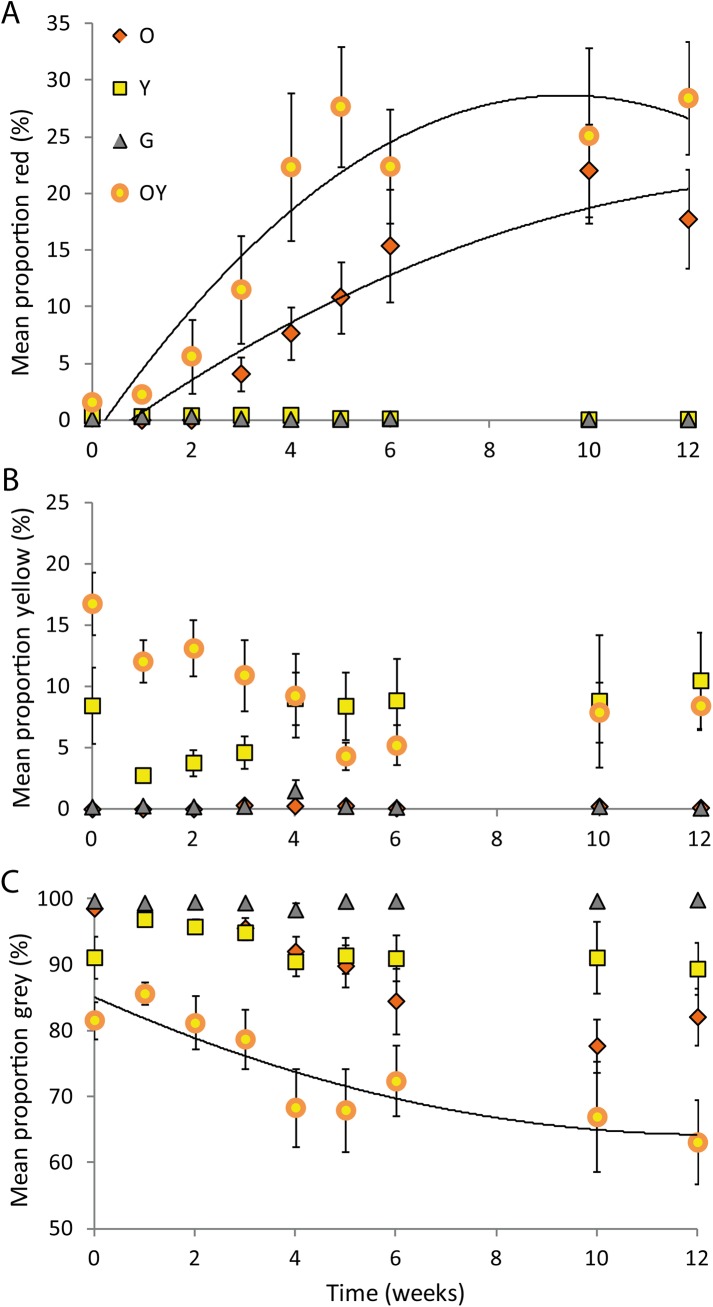
Mean percent of A) red, B) yellow and C) grey components of throat colouration over time.Data for each morph category were derived from digital images using segmentation analysis (n = 40). Significant effect of time for proportion red in O and OY morph, and proportion grey in OY morph (quadratic trendline fitted); p < 0.0001 in each case.